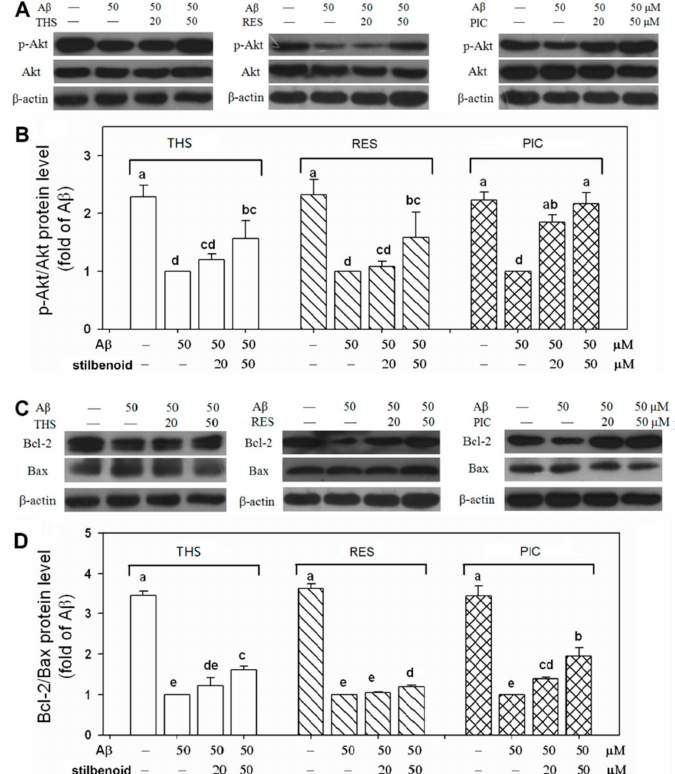
Figure 4. Effects of trans -4-hydroxystilbene (THS), resveratrol (RES), and piceatannol (PIC) on ( A ) Akt phosphorylation and ( C ) Bcl-2/Bax expression in A β 25-35 -induced rat primary cerebral cortex neurons. The relative protein levels of ( B ) p-Akt and ( D ) Bcl-2/Bax were calculated. Each bar represents the mean ± SD of three independent experiments. Different letters in each figure indicate